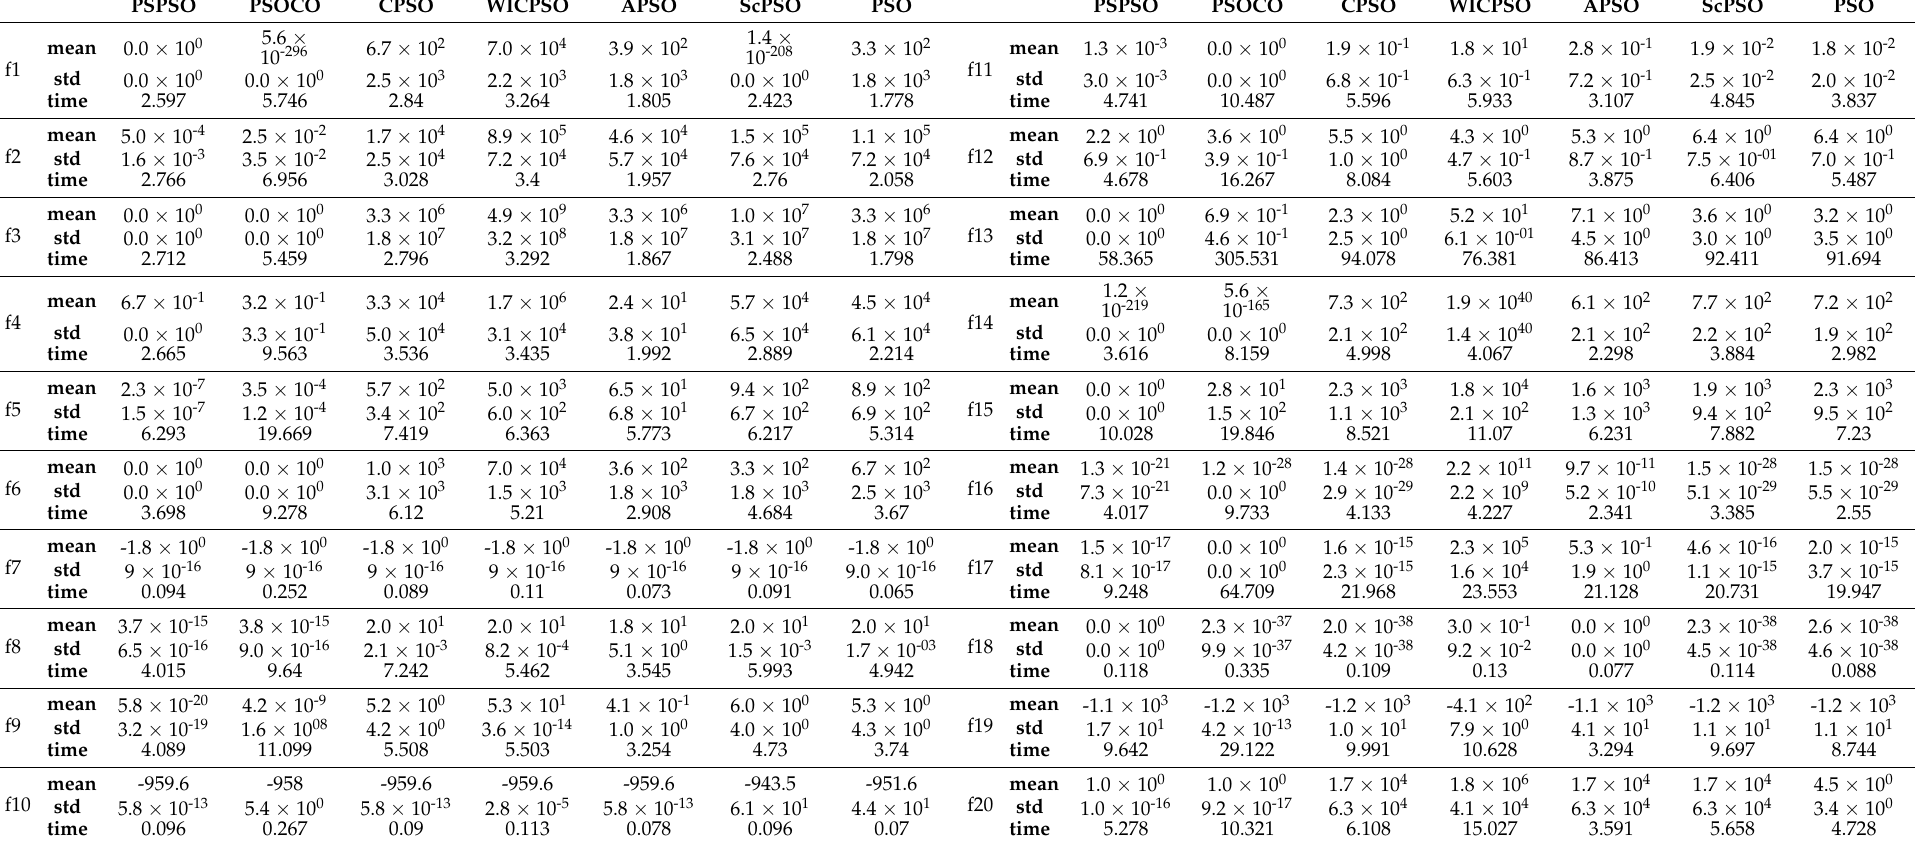
Table 8. Results of benchmark unconstrained functions (D =